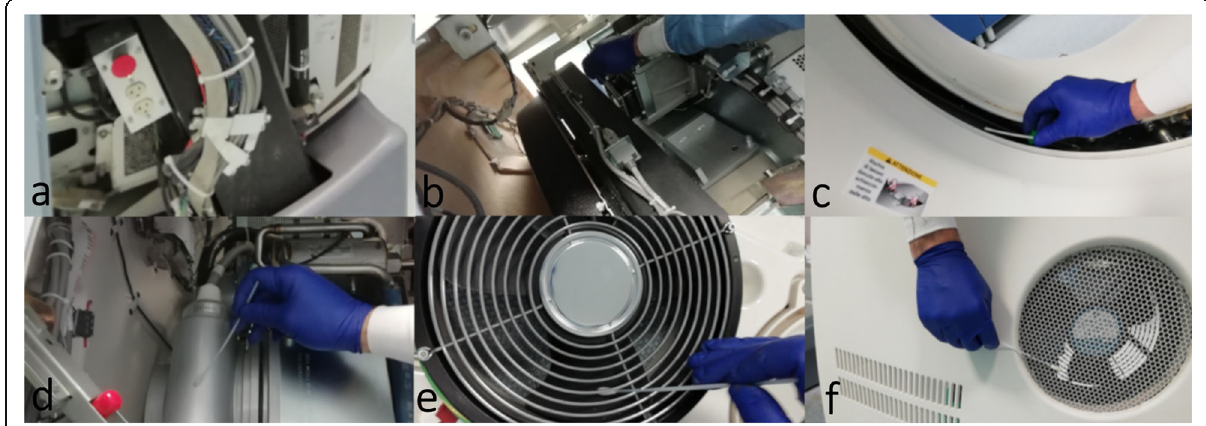
Fig. 1 Computed tomography gantry internal component sampling. a Gantry case. b Inward airflow filter. c Gantry motor. d x-ray tube. e Outflow fan. f Fan